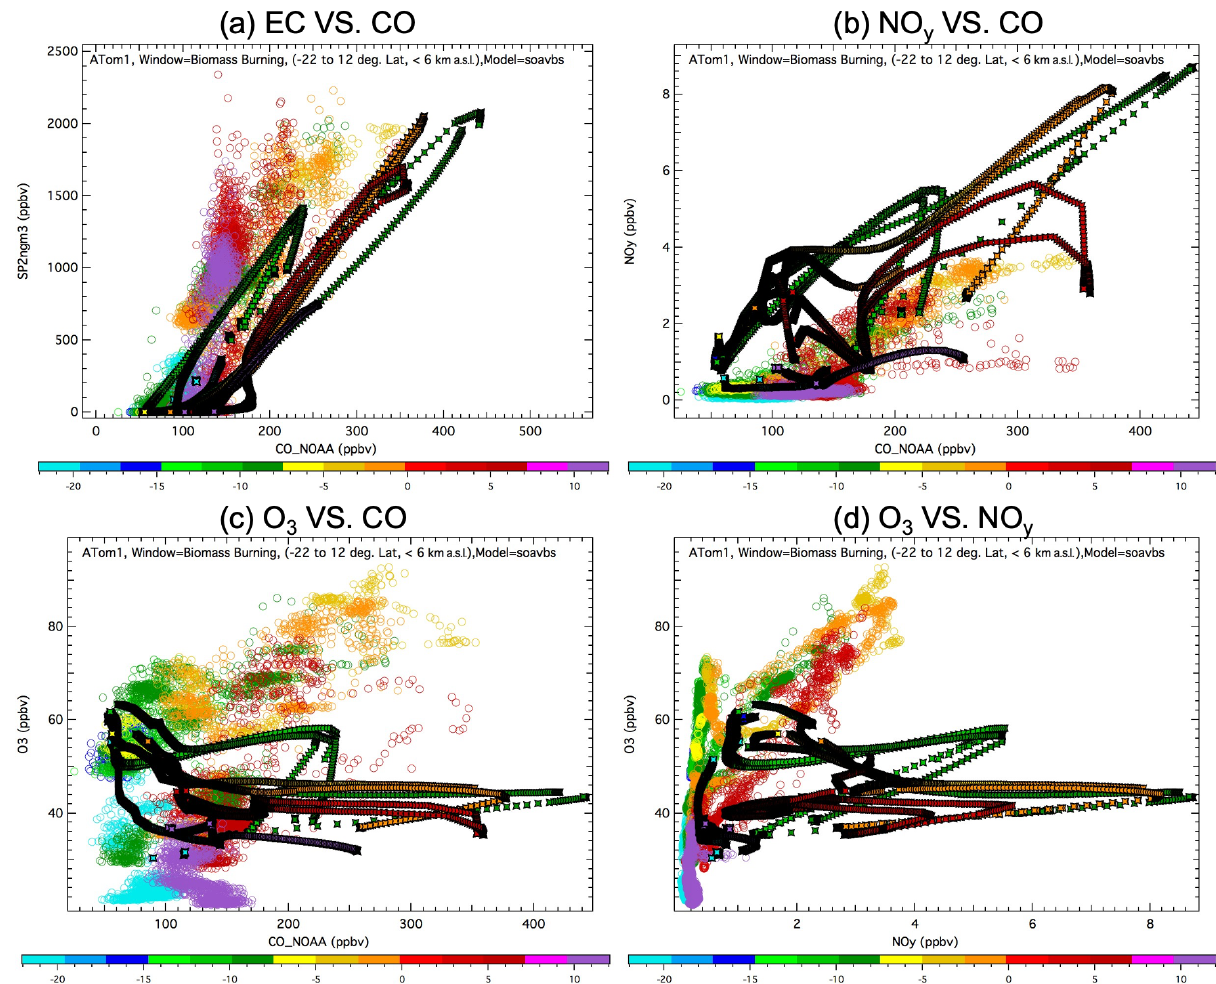
Figure 17. Model (black dot) and observation (color dot) ratios of (a) EC relative to CO; (b) NO y relative to CO; (c) O 3 relative to CO; and (d) O 3 relative to NO y . Color scale indicates degrees